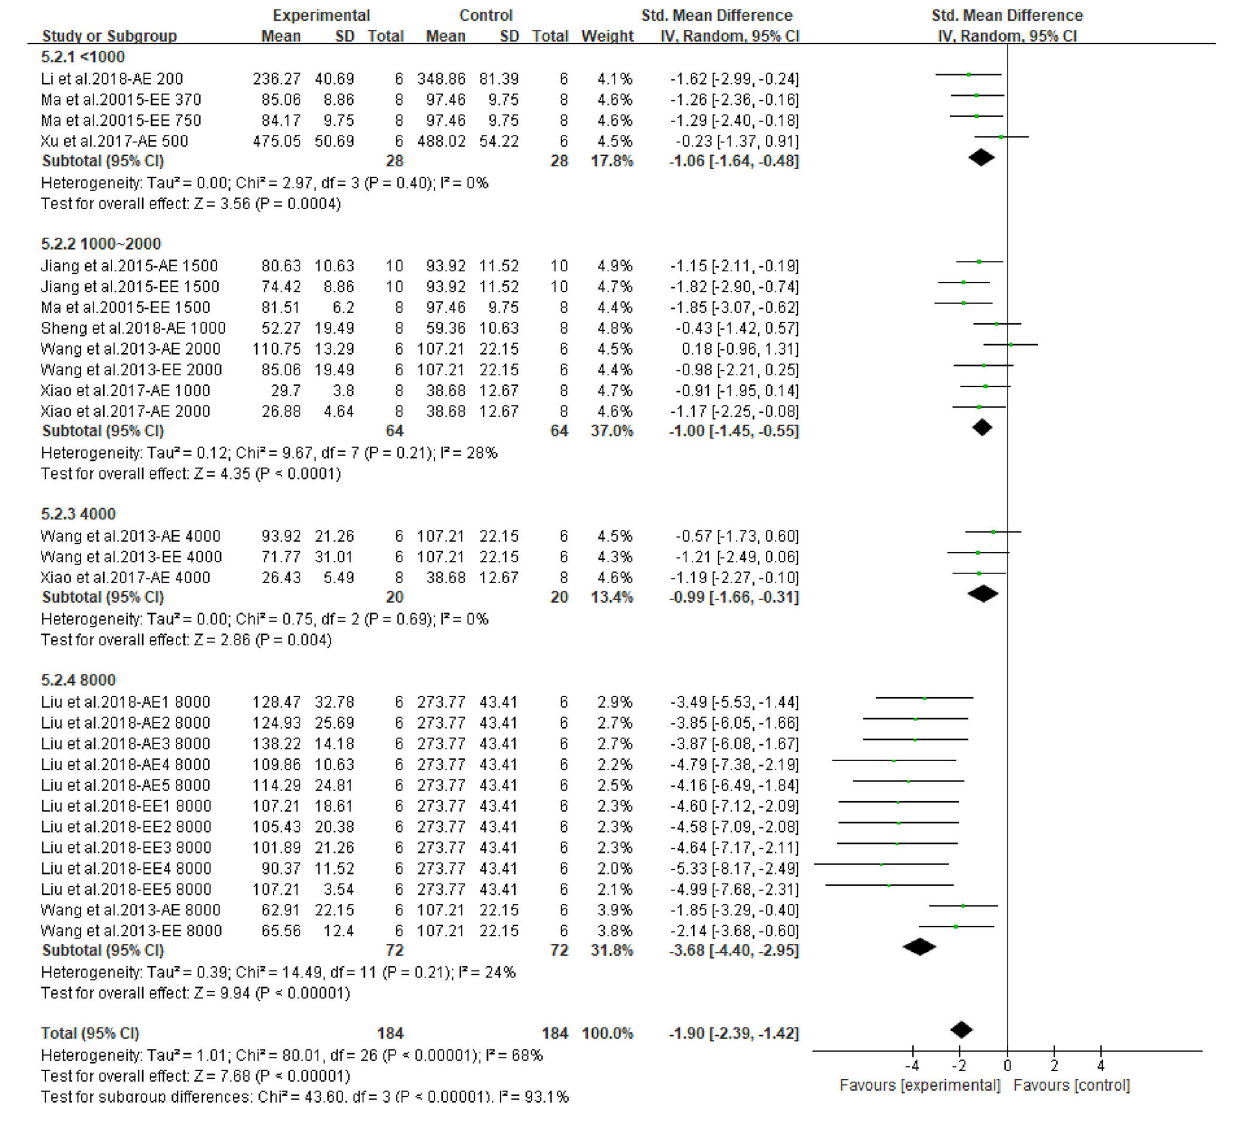
FIGURE 7 | Forest plot for the effect of Cyclocarya paliurus (CP) on triglyceride levels in animal models. Subgroup analysis was performed according to